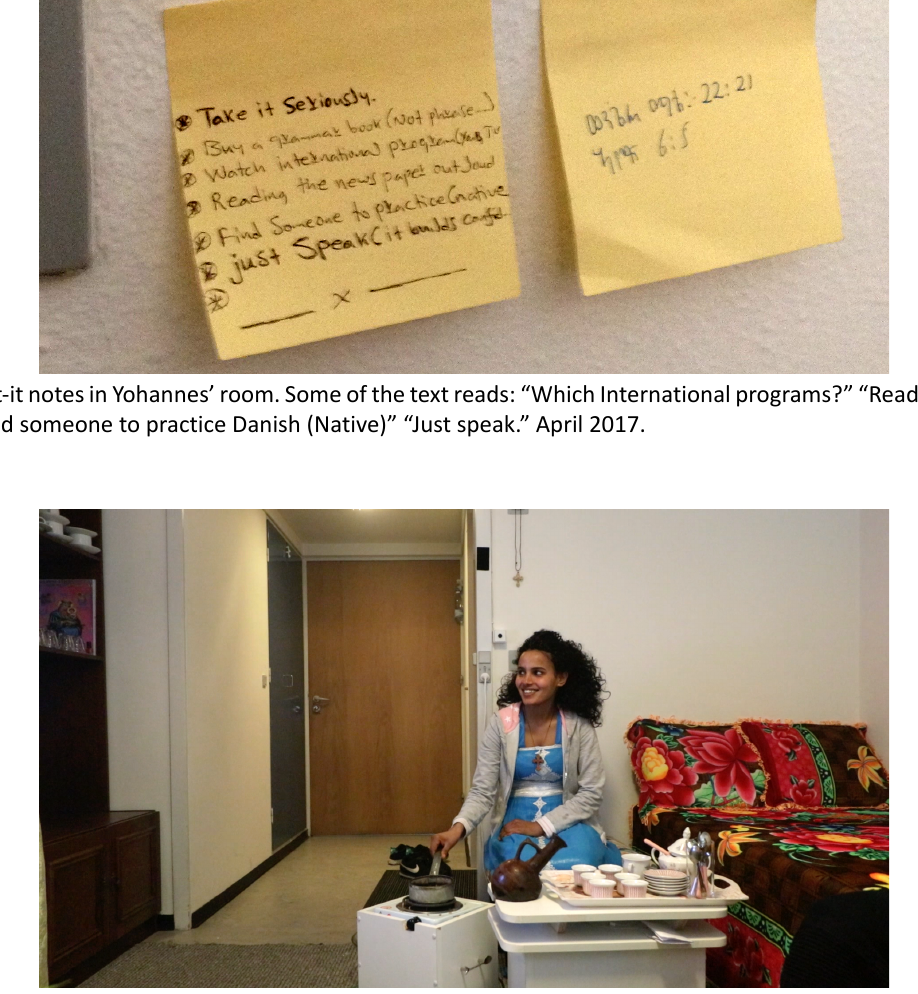
Figure 16. Kistane in her room, preparing Eritrean coffee on a mobile stove. April